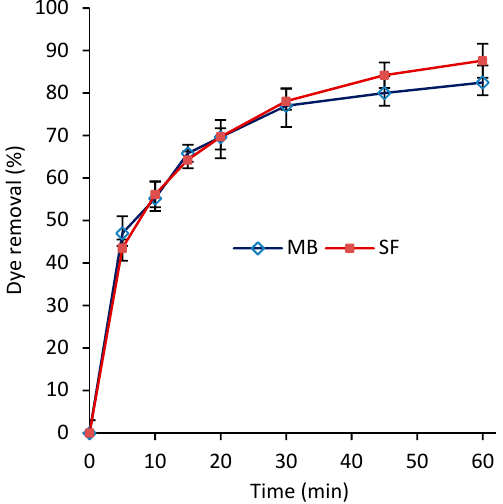
Figure 4. Dye removal percentage versus time for methylene blue (MB) and safranin (SF) (T = 27 °C and C 0 = 50 mg / L).